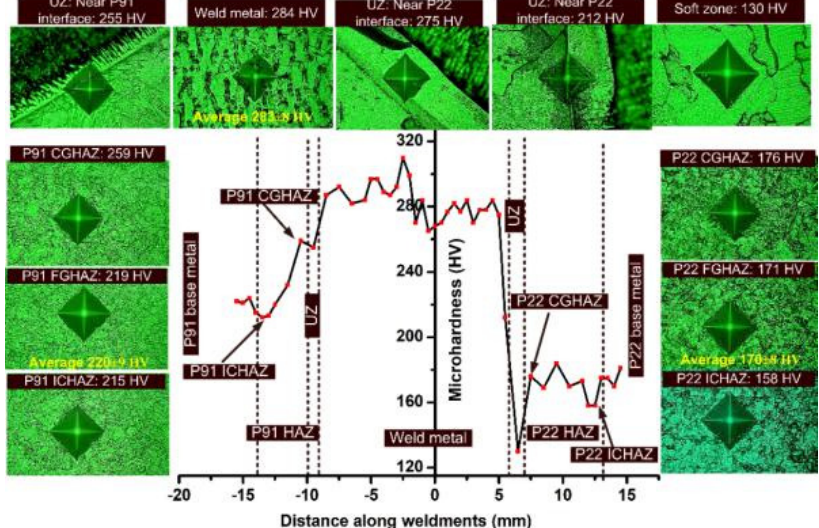
Figure 15. Hardness profile along P22/P91 dissimilar weldments after